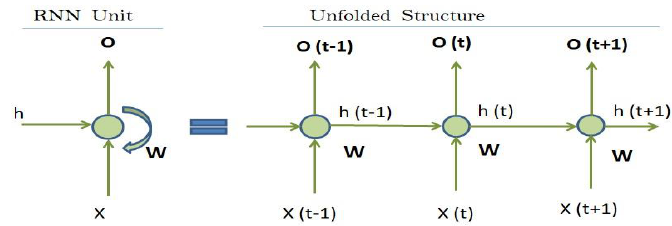
Figure 4. RNN Unit (on the left ) and unfolded structure (on the right